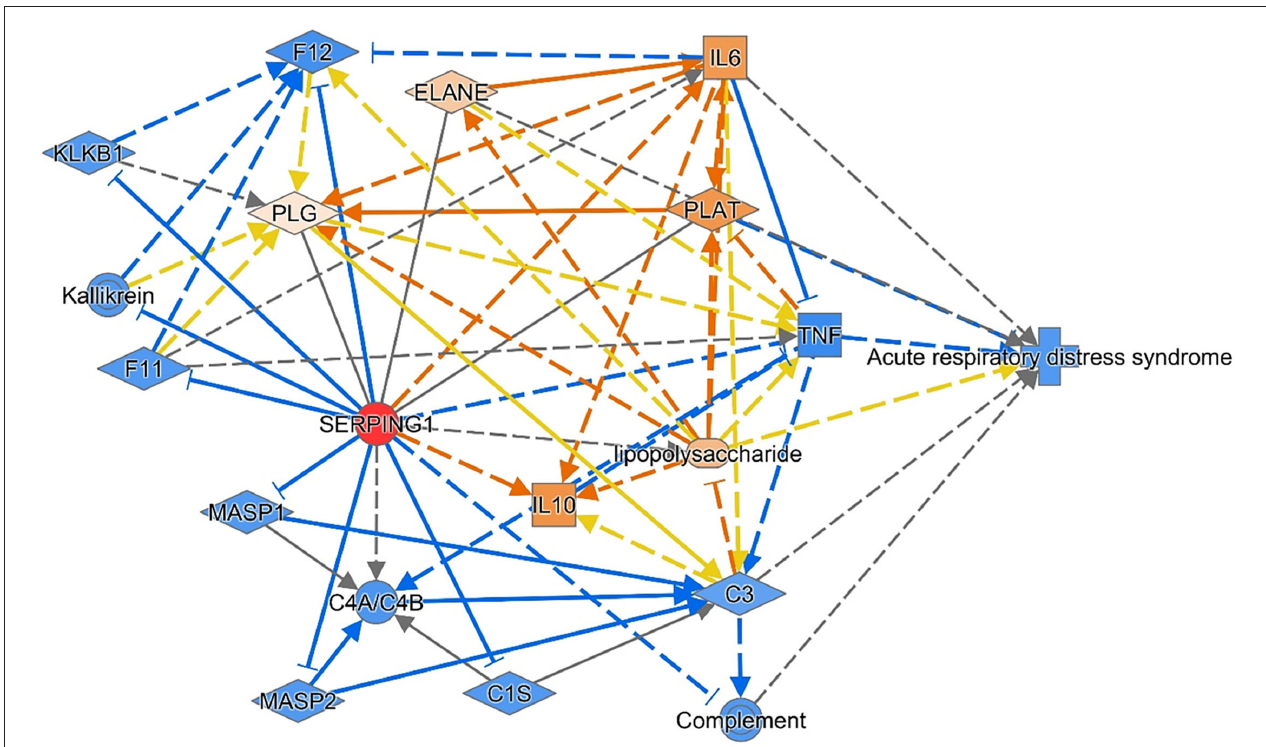
FIGURE 6 | The consequence of the administration of C1INH therapeutic agents is predicted to ameliorate respiratory distress. Reversing the transcriptomic signature of the C1INH ( SERPING1 ) gene was predicted to ameliorate the disease through multiple mechanisms and pathways. The data are retrieved from knowledge-based text mining using Ingenuity Pathway Analysis (IPA) software (Qiagen Co., USA). Red node: the manipulated gene; orange nodes: predicted to be upregulated; and blue nodes: predicted to be downregulated. IL, Interleukin; C, complement; F, clotting factor; KLKB1, Kallikrein B1; MASP1, mannose-associated serine protease 1; PLAT, Plasminogen Activator, Tissue Type; PLG, Plasminogen; TNF, tumor necrosis